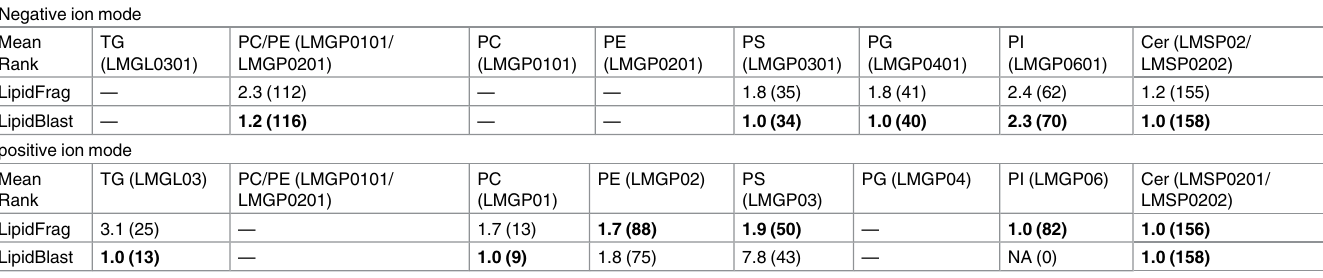
Table 3. Comparison of LipidFrag with LipidBlast